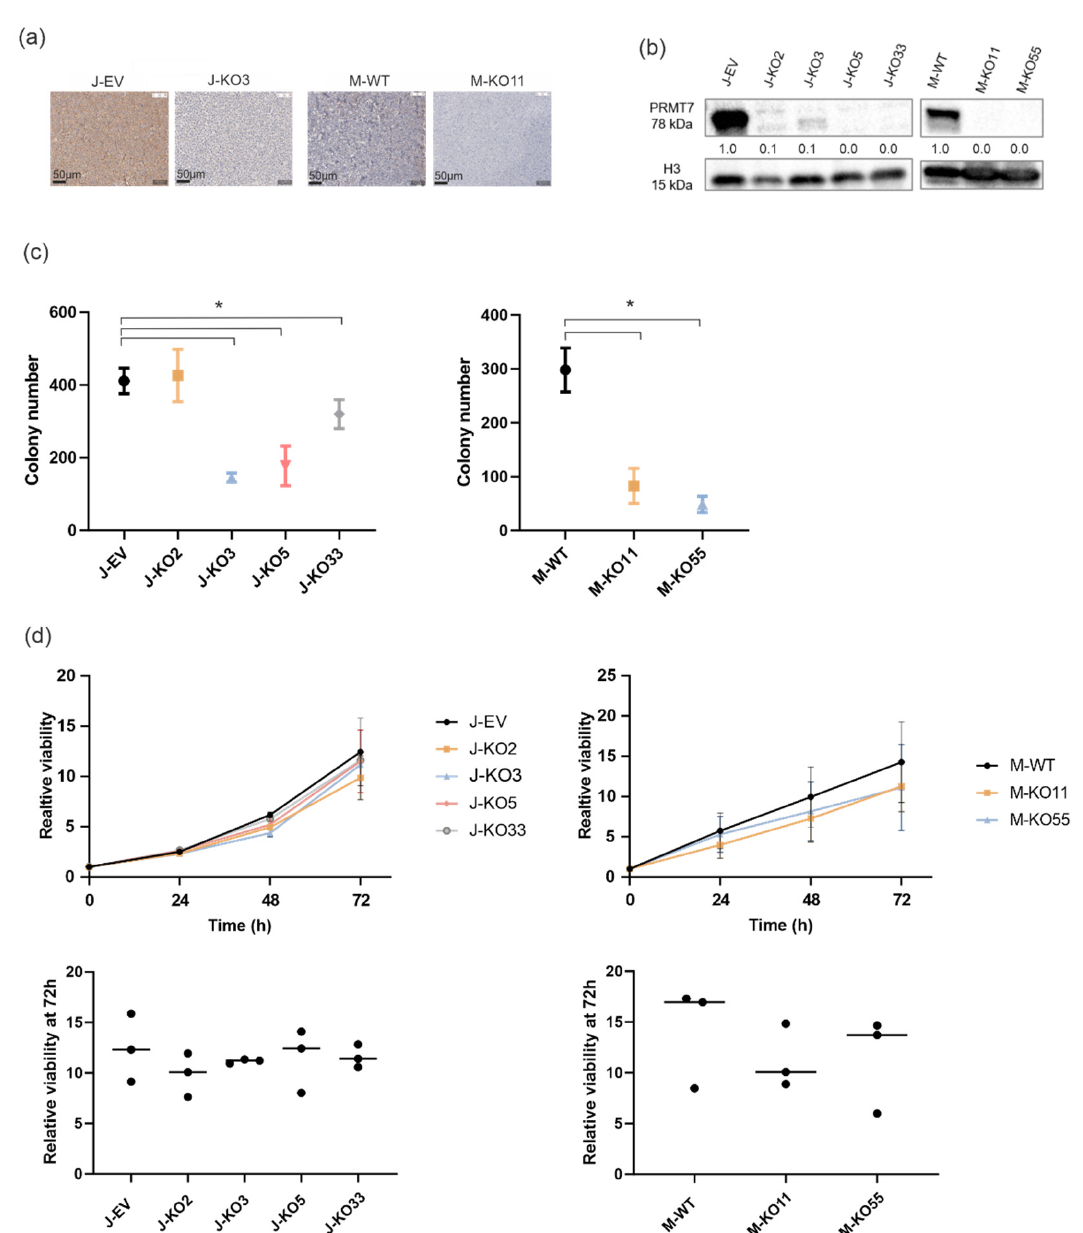
Figure 3. Functional consequences of genetic deletion of PRMT7 in T-ALL cells. ( a ) Immunohisto- chemical staining (scale bar 50 µm) showing PRMT7 expression in J-EV, J-KO3, M-WT and M-KO11 cell lines. Brown color indicates positivity to the PRMT7 protein and blue marks PRMT7 negative cells. ( b ) Western blotting in unmodified (J-EV and M-WT) and knockout cell lines (marked with KO) by using the PRMT7 antibody. Quantitation in Western blot is relative to J-EV or M-EV control cell lines. J stands for Jurkat and M for Molt4 cell line, EV for empty vector and WT for wild type. The uncropped Western blots have been shown in Figure S6. Effect of the PRMT7 knockout on ( c ) colony formation ( n = 4) and ( d ) cell viability ( n = 3). Cell viability results are presented as line plots for all the examined time points and as scatter plots for the 72 h time point. Asterisks denote samples with significant p -values (<0.05) when compared to the unmodified (J-EV and M-WT)